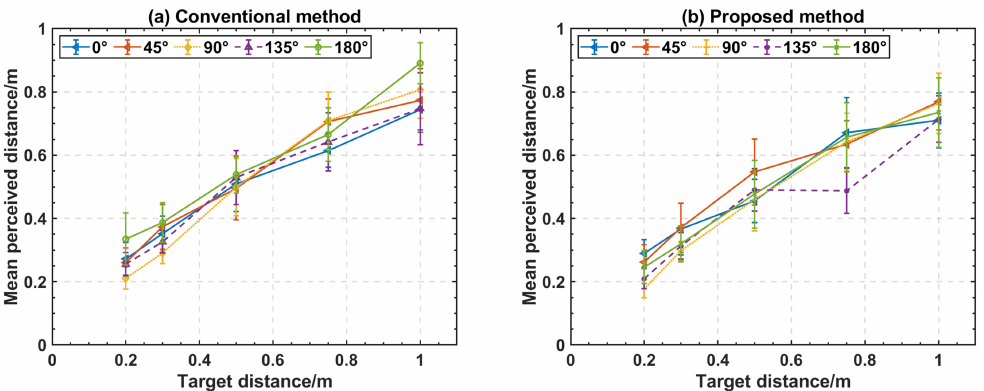
Figure 4. Results of distance perception for virtual sources on the horizontal